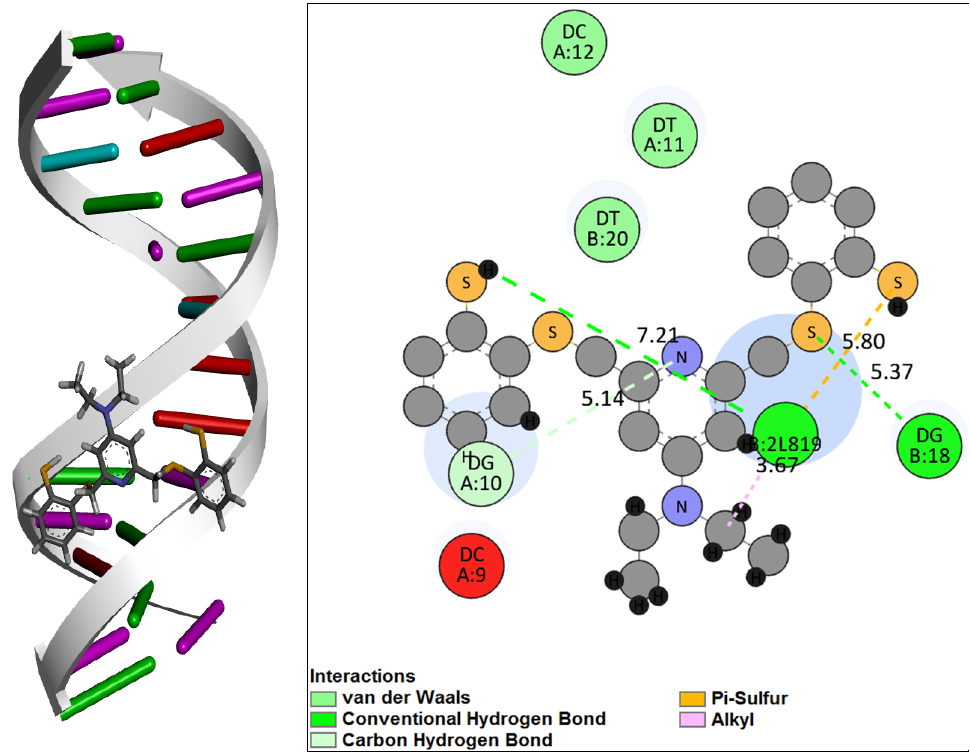
Figure 14. TSPH 2 docked to major groove of DNA fragment (2L8i) as in the fi rst view to the left while in the second view displays di ff erent types of interactions between TSPH 2 and DNA bases.